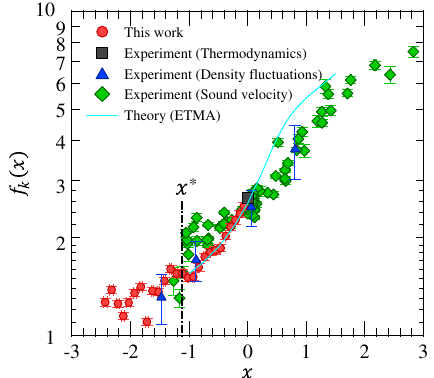
FIG. 6. Experimental and theoretical dimensionless isothermal compressibility. The vertical axis follows a logarithmic scale. The red circles indicate the experimental data of the present study. The green diamonds, blue triangles, and black square indicate exper- imental values obtained based on the speed of sound [21], density fluctuations [20], and thermodynamic measurementsat the unitarity limit [19], respectively. The light blue curve indicates the theoretical calculationofETMA[31,32].Theverticaldash-dottedlineindicates the superfluid transition point x (cid:4) obtained in the present